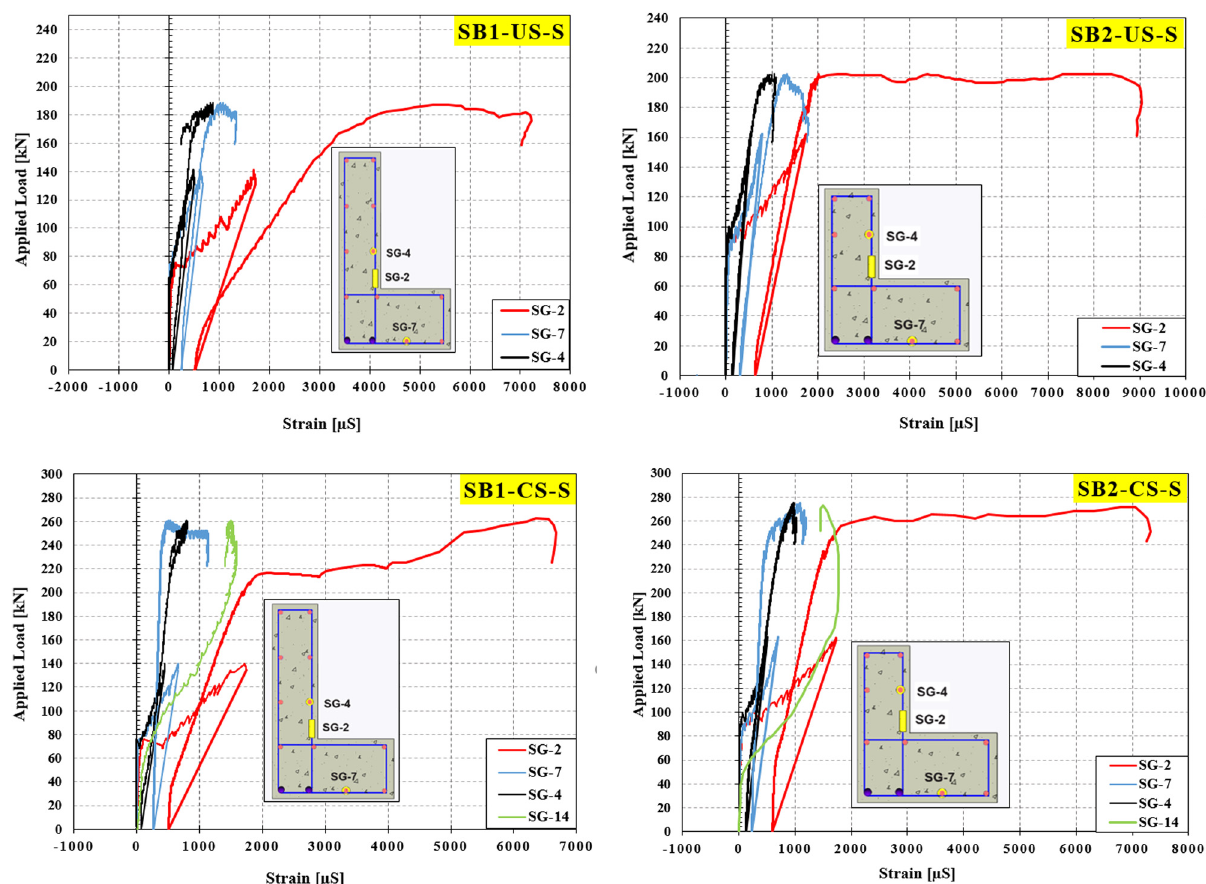
Figure 12: Load – strain curves in steel reinforcement and CFRP strips at di ff erent loading